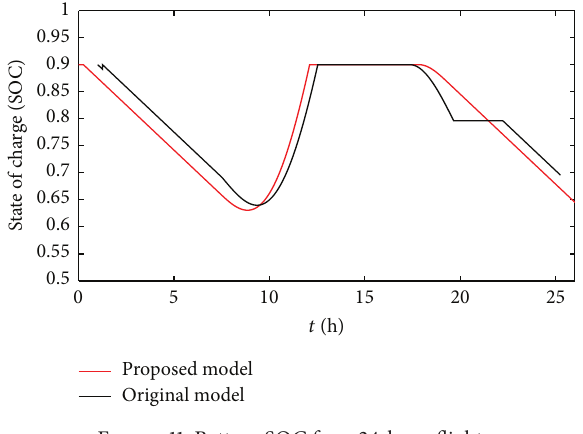
Figure 11: Battery SOC for a 24-hour flight. Table 2: 24-hour flight mission performance data.